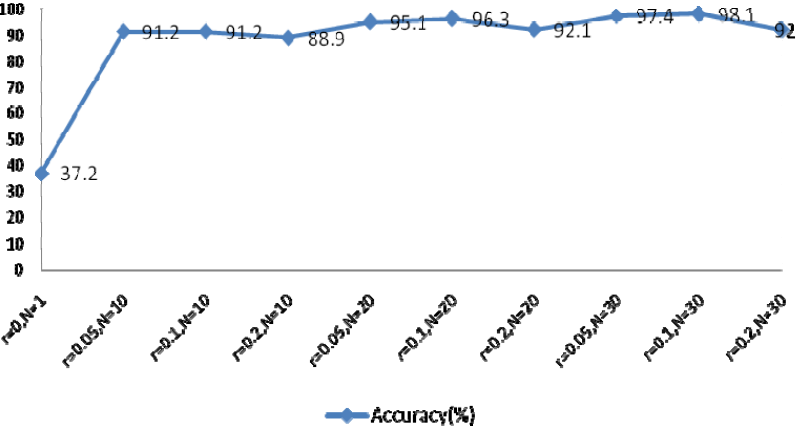
Figure 22. System performance with different r and N